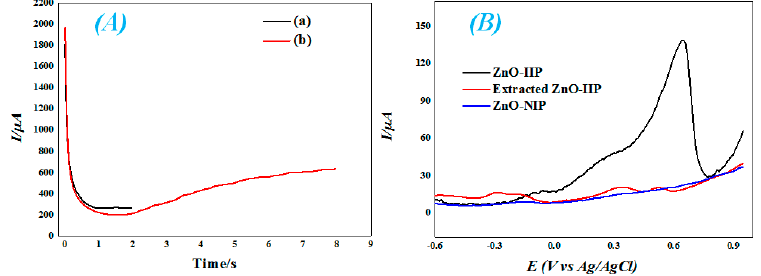
Figure 2. ( A ): Electropolymerization of pyrrole by chronoamperometry. (a) Barrier layer, (b) Polymerization of pyrrole in the presence of L-cysteine and Hg 2+ . ( B ): SWV of IIP and